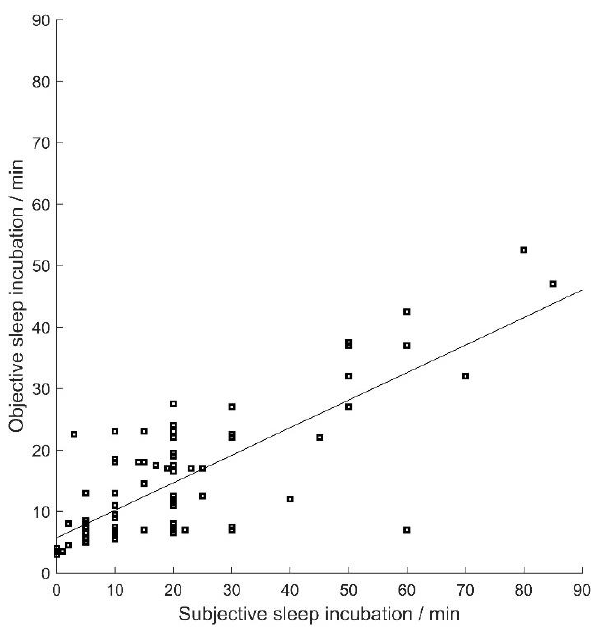
Figure 8. Corresponding relationship between subjective and objective sleep incubation (Each spot represents at least one subject for some of spots overlap. The straight line is their least-square fitting